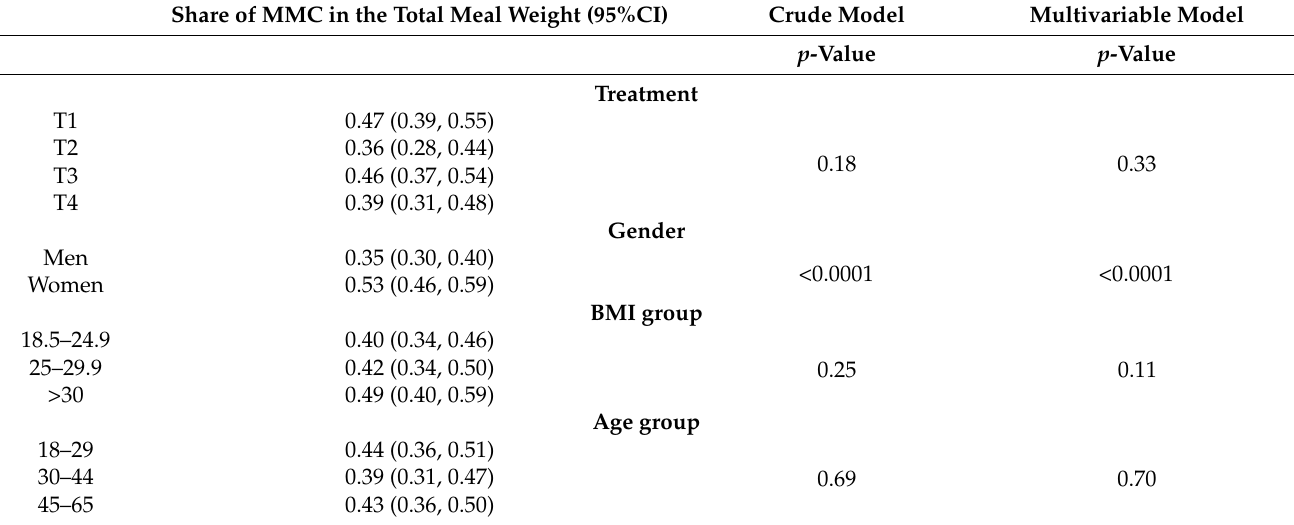
Table 4. Share of the minced meat casserole (MMC) in the total meal weight by treatment, gender, body mass index (BMI) group, and age group. Analyses were conducted using linear